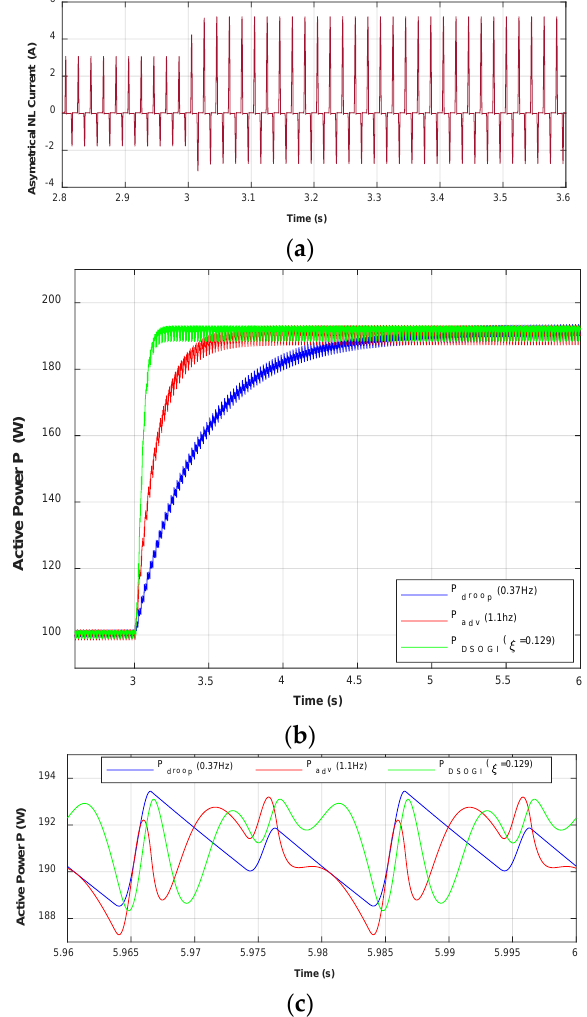
Figure 15. Simulation of the load current and P av transient responses for an asymmetrical nonlinear DBR load current with a positive peak of 5.21 A and a negative peak of − 3.07 A after the perturbation at 3 s: ( a ) detail of the asymmetrical load current perturbation, ( b ) P DSOGI , P adv and P droop , ( c ) detail of P DSOGI , P adv and P droop ripples.